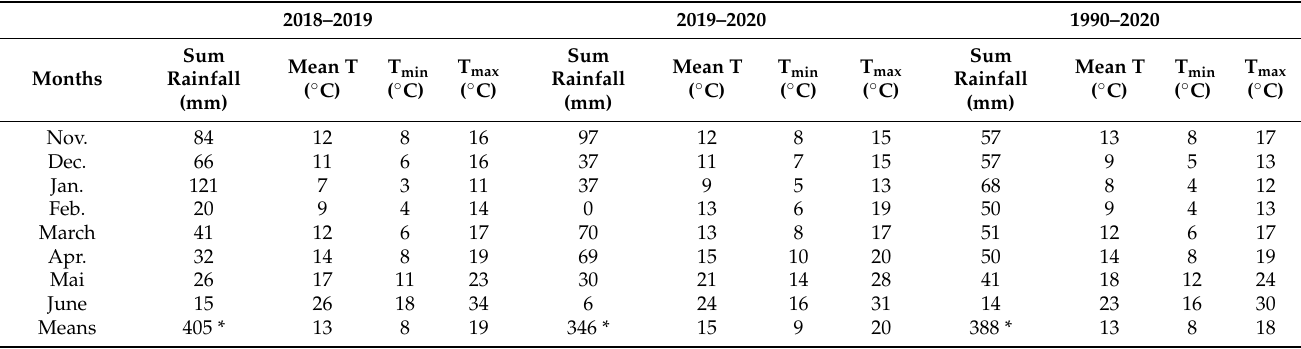
Table 2. Monthly rainfall and mean maximum and minimum temperature for the 2 years of the study (2019–2020) compared to the long-term data (1990–2020) recorded in the study